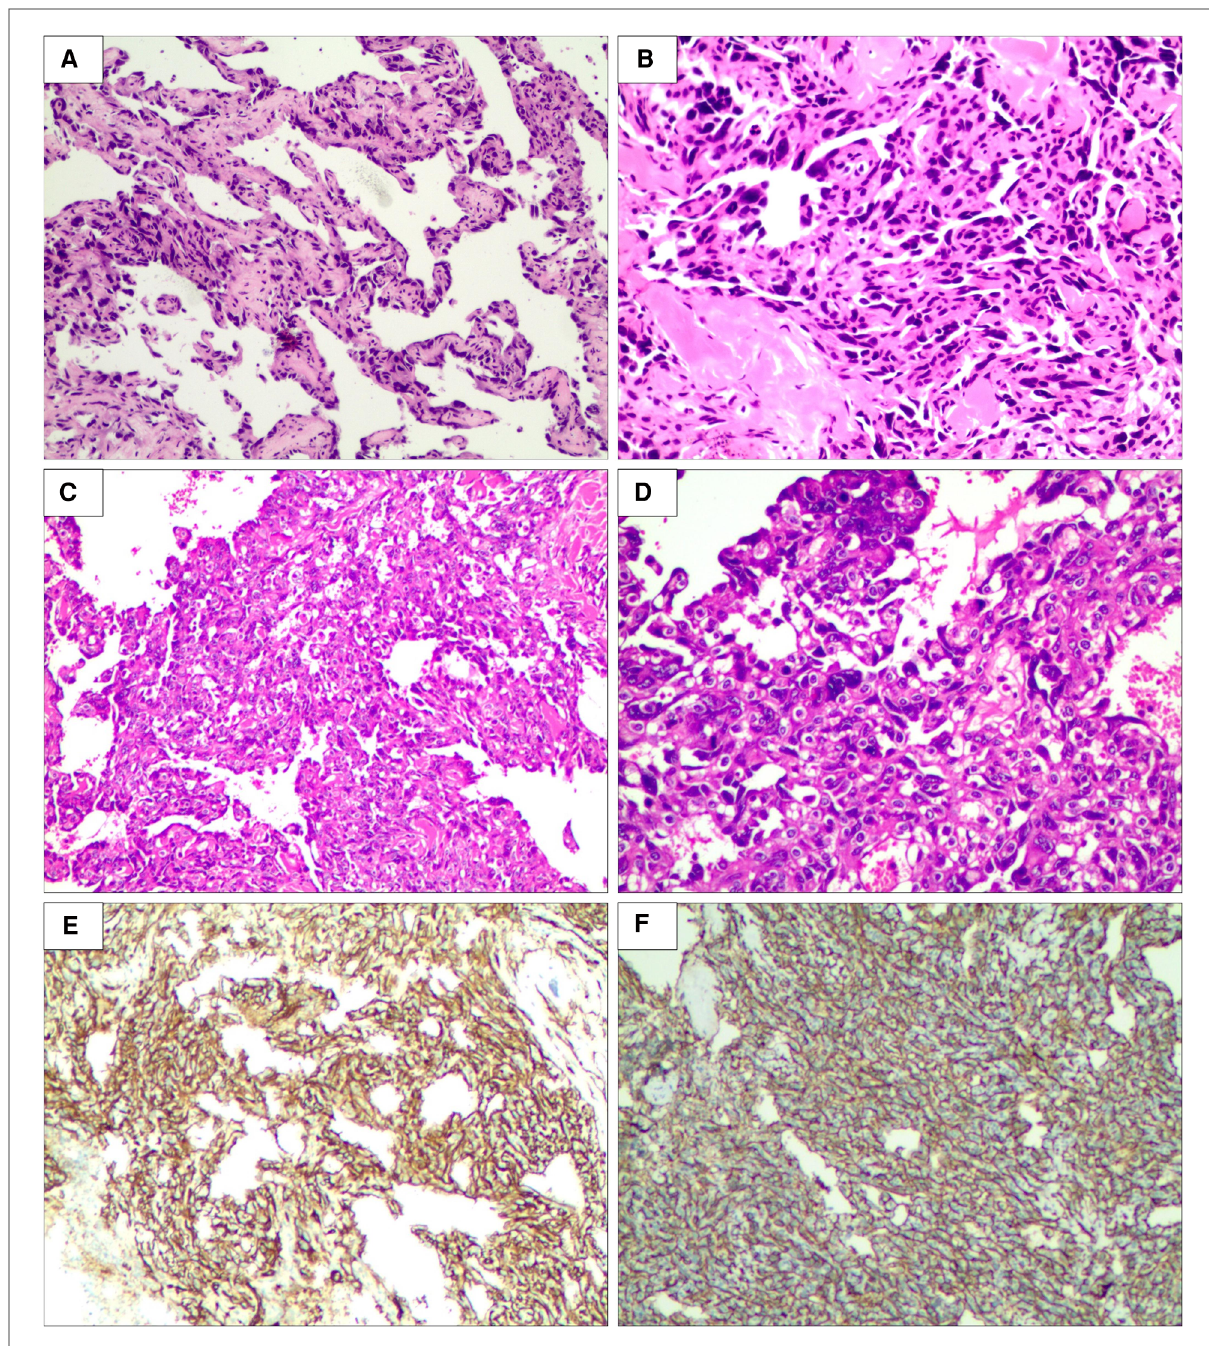
FIGURE 3 Biopsy of right breast lesion microphotography. The tumor is composed of atypical endothelial cells with different degrees of differentiation, forming irregular vascular cavities that coincide with each other, forming papillary and diffuse in fi ltration (×200, ( A ) punch biopsy and ( C ) excisional biopsy). Tumor cells exhibit fusiform or irregular shapes with little cytoplasm and hyperchromatic nuclei (×400, ( B ) punch biopsy and ( D ) excisional biopsy). Special stain CD31 positive ( E ). Special stain CD34 positive ( F ) (hematein – eosin